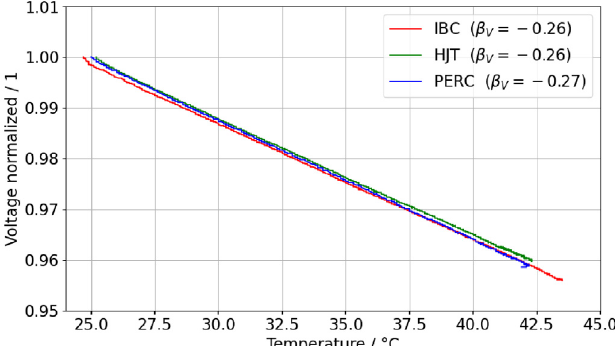
Fig. 5. Normalized voltage versus the temperature for all three modules investigated. Resulting b V as average over the whole measurement with standard deviations given in Table